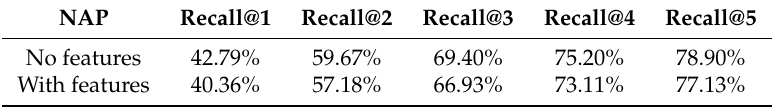
Table 1. Recall@k comparison results using the features and without the